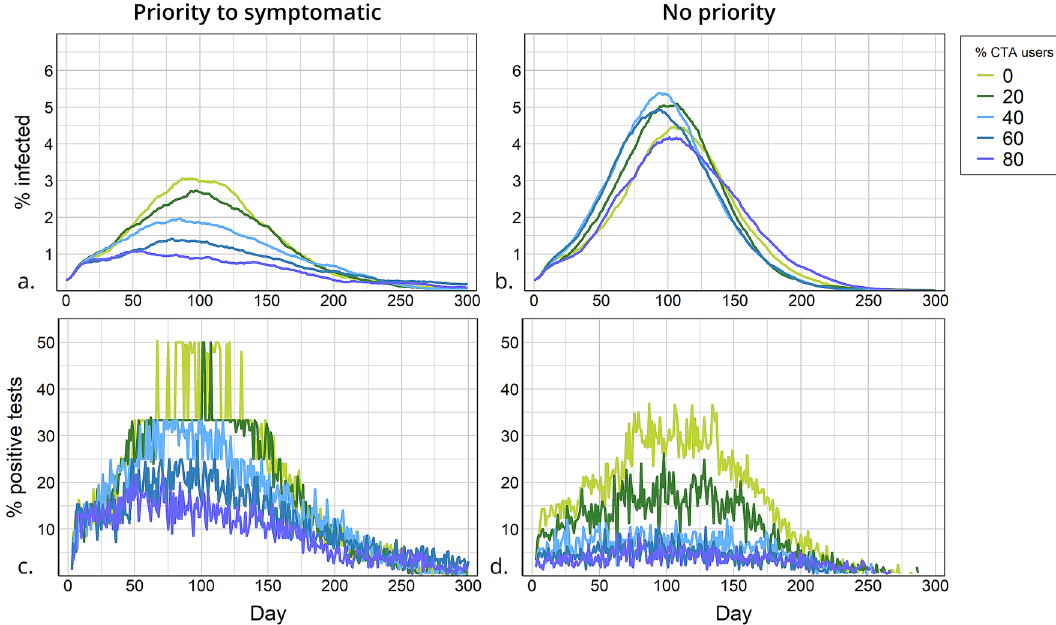
Figure 6. Infection prevalence and positive tests for a testing policy with and without priority to symptomatic cases. Percentage infected ( a ) and percentage of positive tests ( c ) by day, for a testing policy with priority to symptomatic. Percentage infected ( b ) and percentage positive tests ( d ) by day, for a testing policy without priority. Percentage of CTA users in the scenario is marked by line colour. In these scenarios: testing capacity = 1.5% and CTA compliance is high. Note that in the scenarios with no CTA users, although only symptomatic cases are tested, the percentage of positive tests is not 100% because of cases with influenza-like illness that are also being